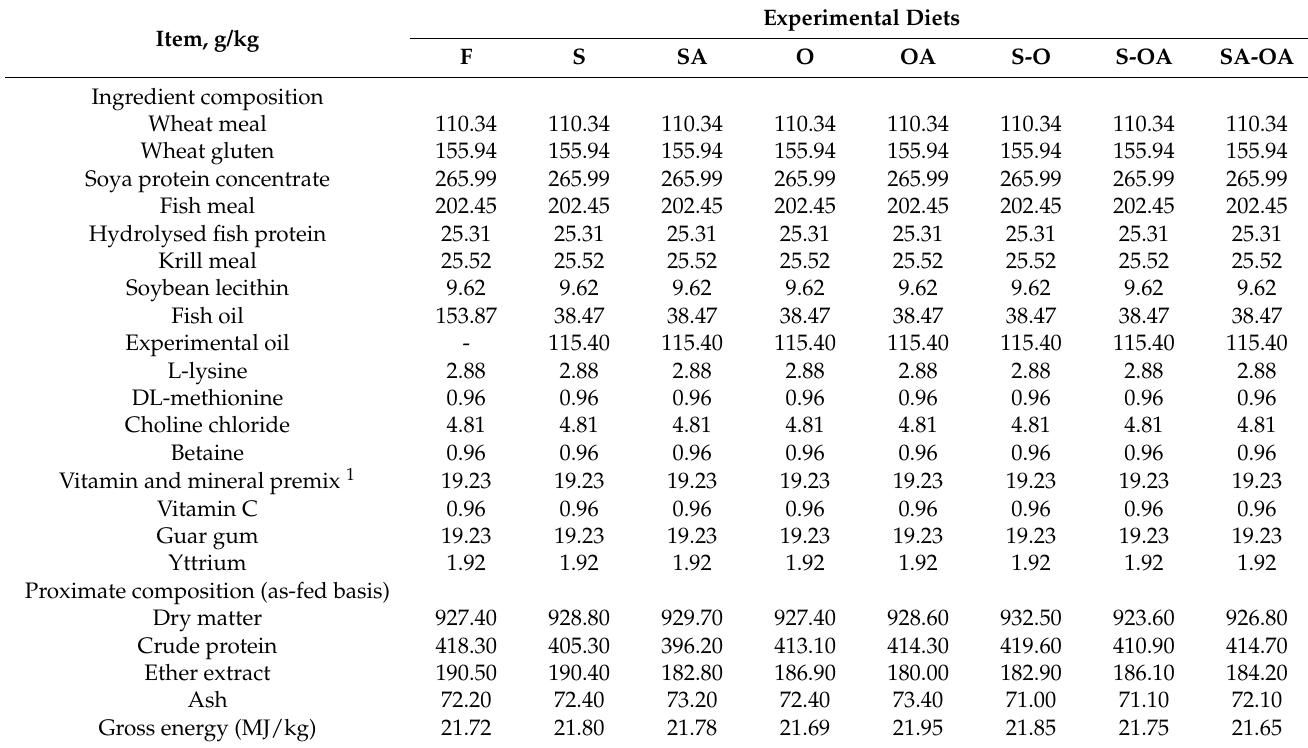
Table 1. Ingredients and approximate composition of experimental